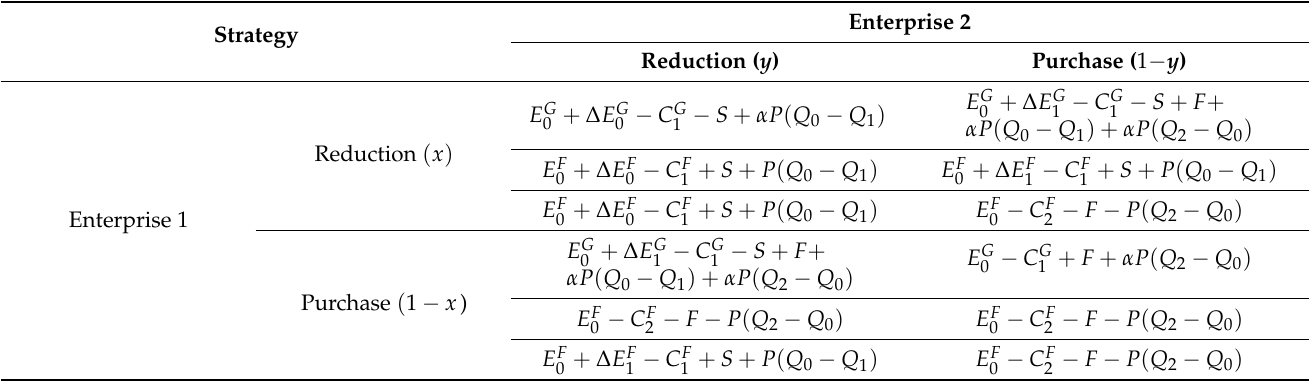
Table 5. Tripartite evolutionary game payoff matrix with government participation.